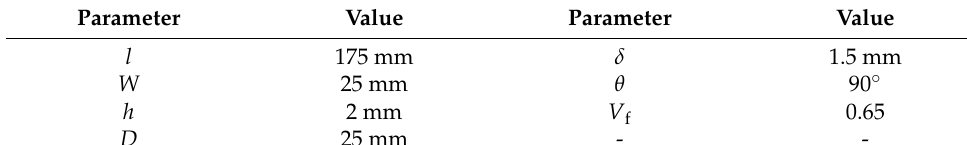
Table 1. Constituent properties of CCF800H/AC531. Table 2. Nominal values of geometrical parameters for the specimen.